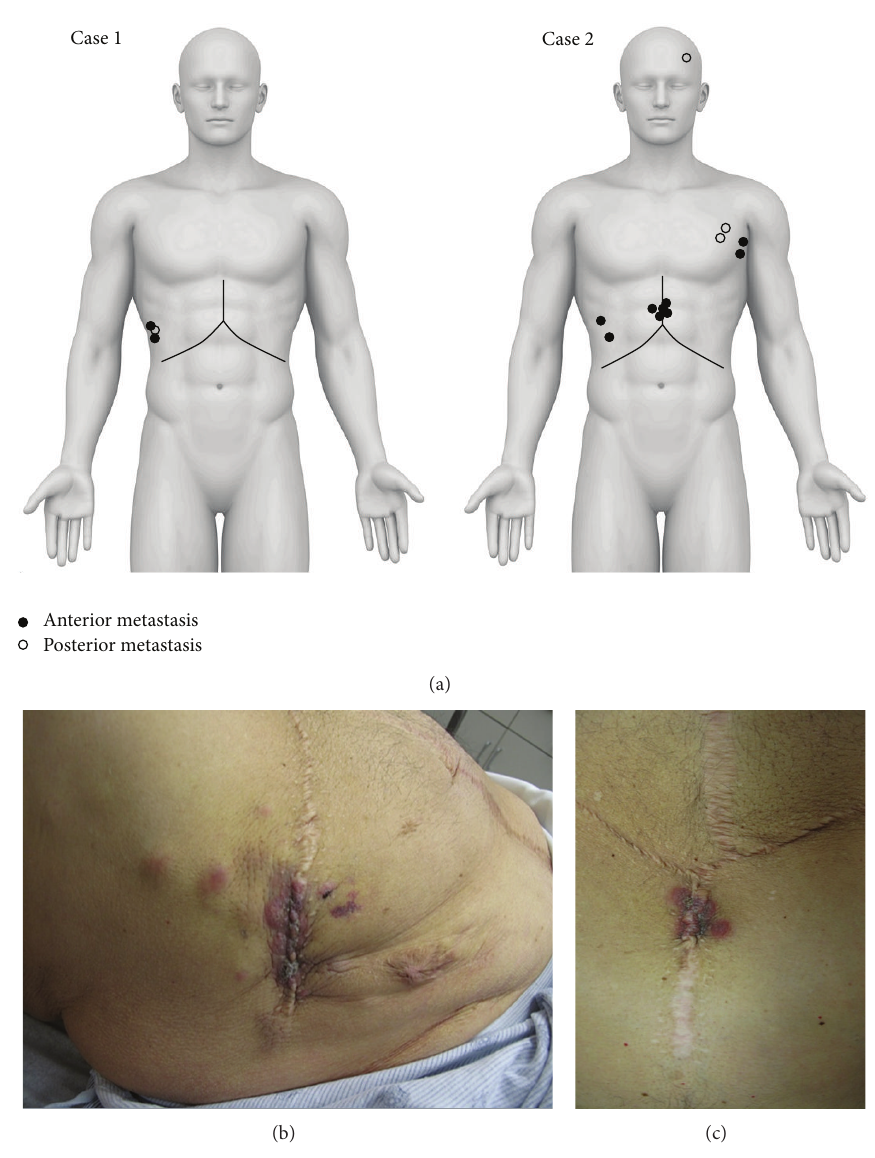
Figure 1: (a) Illustration demonstrating locations of cutaneous metastases for patients of Case 1 and Case 2. (b and c) Multiple erythematous- violaceous metastatic lesions with irregular borders representing mixed HCC/cholangiocarcinoma found at the previous incision site of the patient in Case